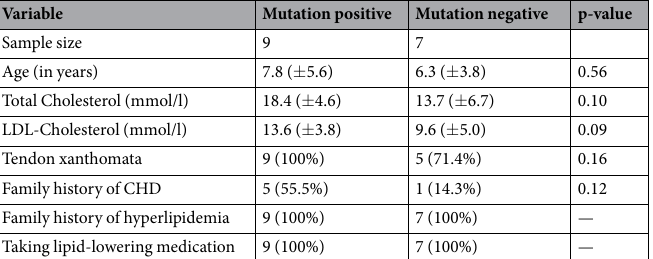
— Table 2. Familial hypercholesterolemia (FH) patient characteristics: mutation positive and negative groups in the Iran study. Mean and Standard deviation (SD), where appropriate, are shown. P-value was determined using ANOVA for numeric variables and chi-squared test for categorical